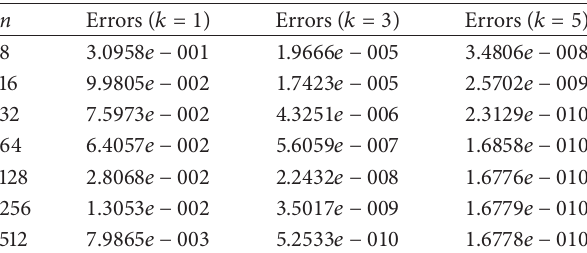
5 ln (𝑥)𝑑𝑥 by NMI. 1